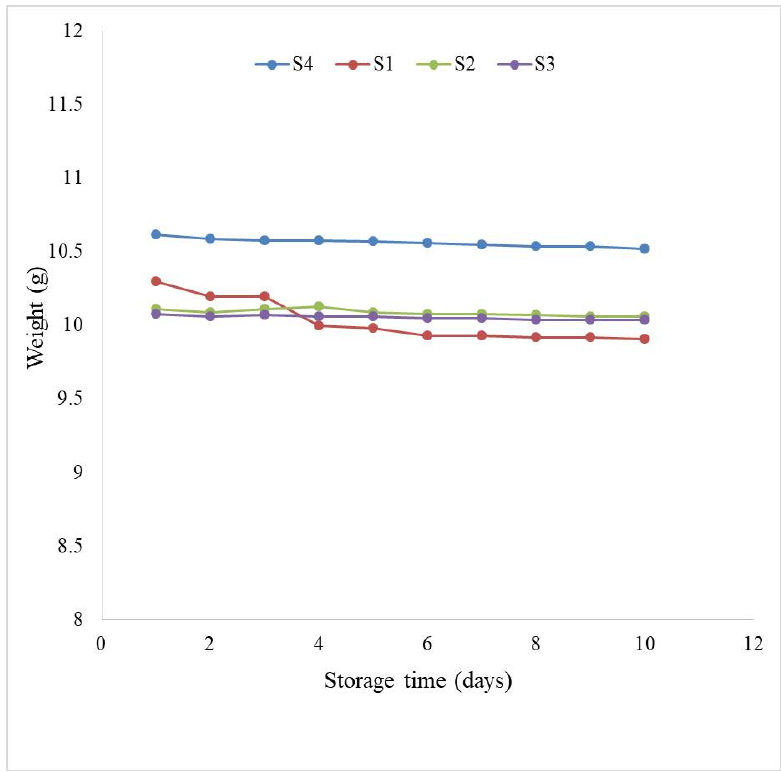
Figure 2. Changes in weight of control and Aloe Vera leaf powder (ALP) incorporated plain cakes during storage period at room temperature (30 ± 2 °C) .